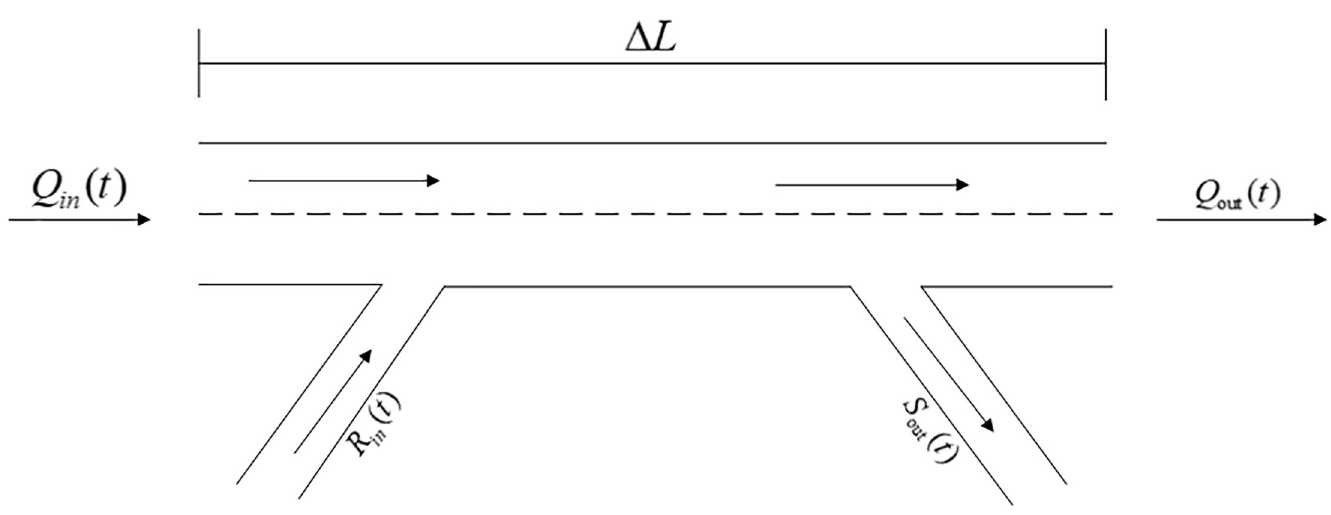
Fig 1. Freeway weave section with on/off ramp schematic